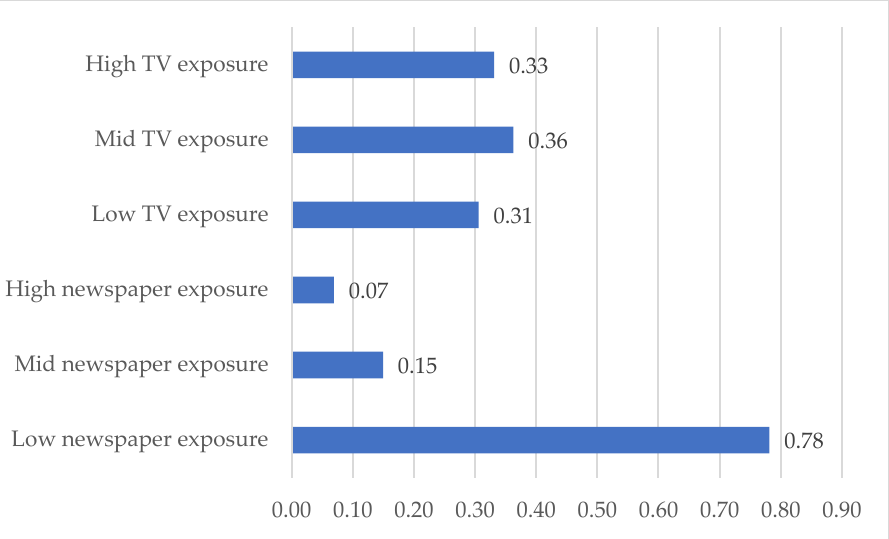
Figure 3. Weighted proportions of media exposure.